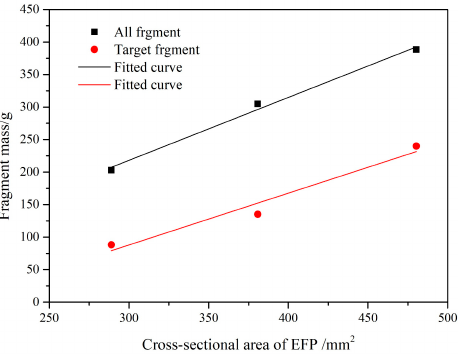
Figure 11. The relationship between fragment total mass and EFP cross-sectional